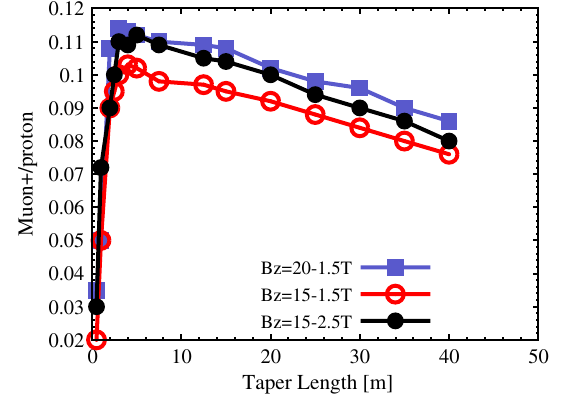
FIG. 13. Schematic showing a set of realistic superconducting solenoids giving a good approximation to a field profile having a 20 T target field, 2.5 T final field, and 5 m taper length. Rectangles are solenoids. The solenoids near z ¼ 0 with radius less than 1 m are resistive, the rest are superconducting. A curve giving the solenoid field on axis is also